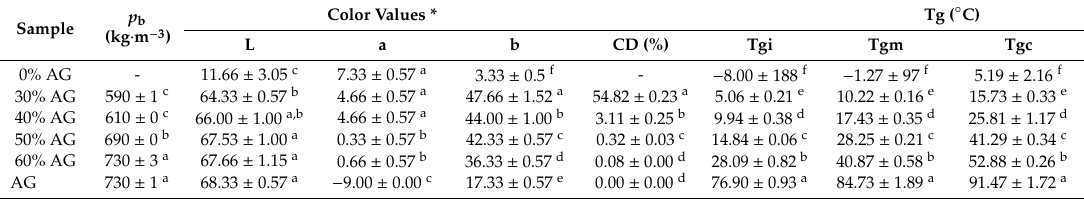
Table 3. Glass transition temperature (Tg), caking degree (CD), color parameters (L, a, and b), and density ( p b ), of samples with various acacia gum concentrations. 0% AG: 100% DS-0% AG; 30% AG: